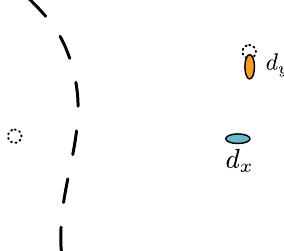
Figure 5: (Left) A net charge to the left of the dashed line has a part- ner in the complement region.